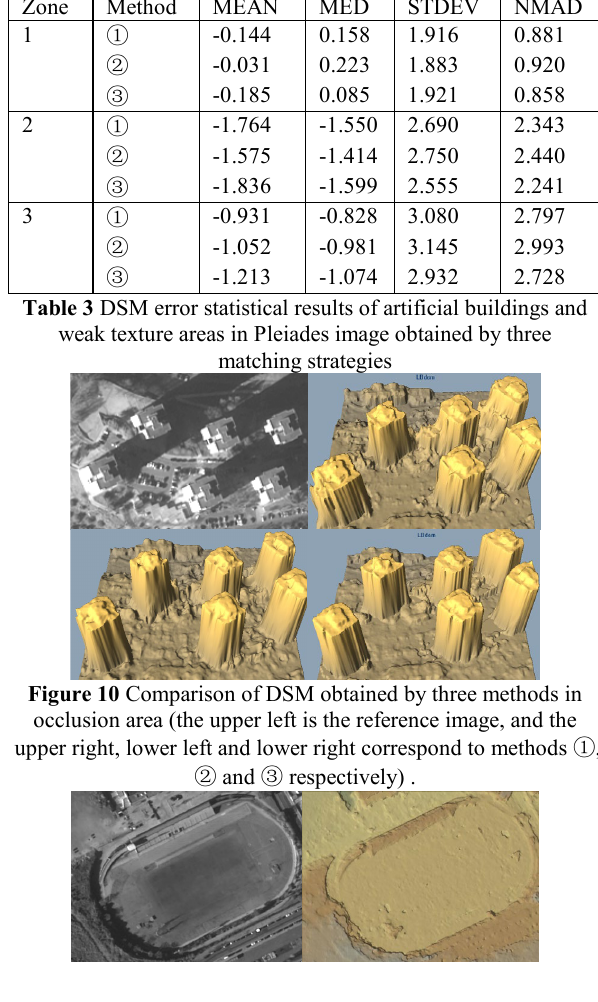
Figure 8 Pleiades region 3 weak texture region.